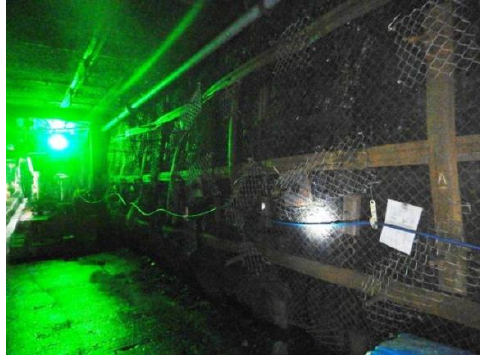
Figure 16. Field observation of roadway stability.